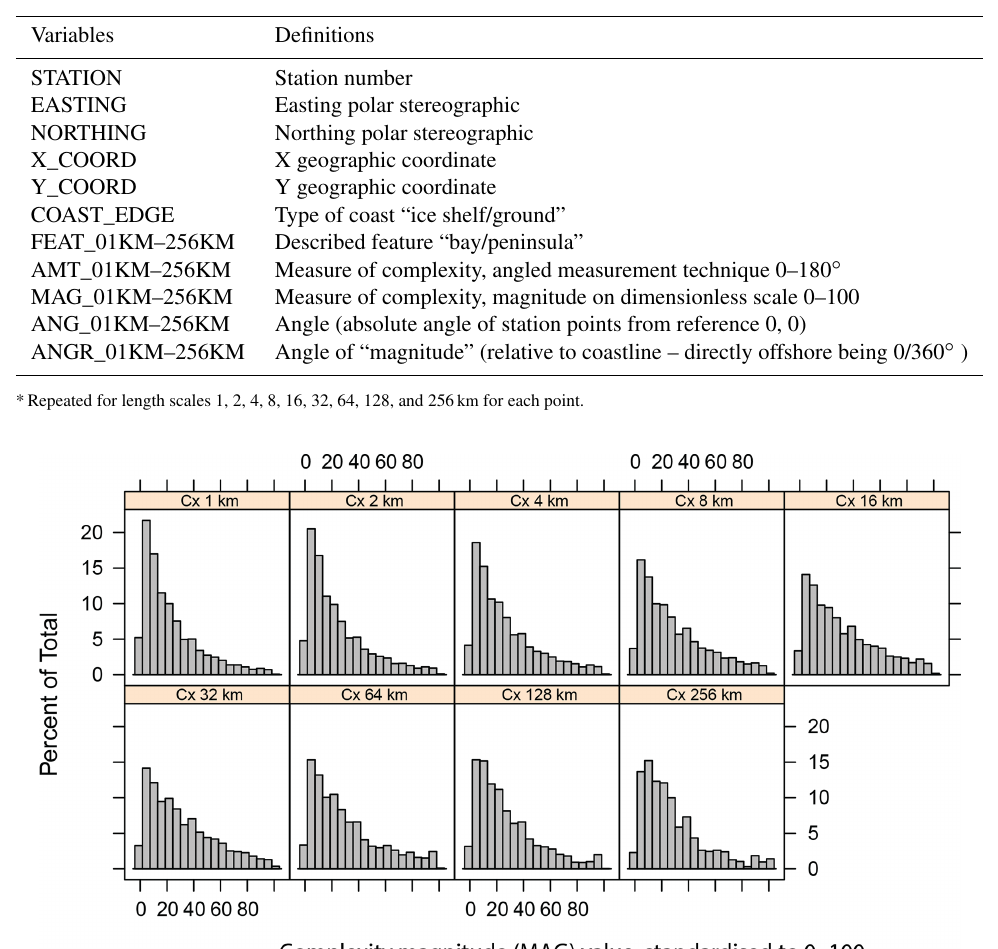
Table 1. List of fields and their descriptions.